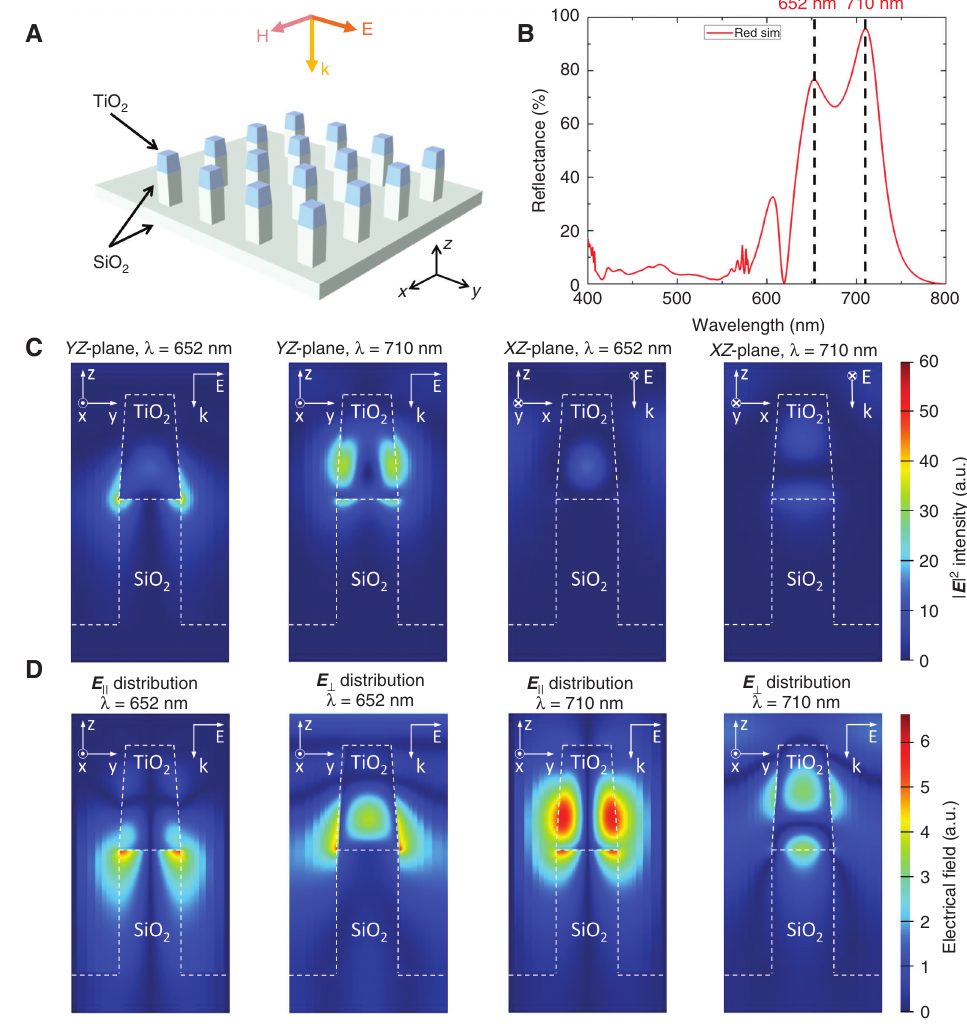
Figure 2: Numerical calculations of the ideal all-dielectric metasurface. (A) Schematic of the ideal all-dielectric metasurface for the red light band reflector, which has two layers (TiO reflection spectrum of the ideal all-dielectric metasurface at normal incidence. There are two reflection peaks at 652 and 710 nm. (C) | E | 2 distributions of the ideal all-dielectric metasurface at different wavelengths (652 or 710 nm) in different planes ( YZ -plane or XZ -plane). (D) Electrical field component ( E or E ) distributions of the ideal all-dielectric metasurface at different wavelengths (652 or 710 nm) in the ⊥ ‖ = E YZ -plane, where = + . E represents the electrical field component that is parallel to the nanopillar surface, while E E E and E (cid:31) ⊥ y ‖ represents the electrical field component that is perpendicular to the nanopillar